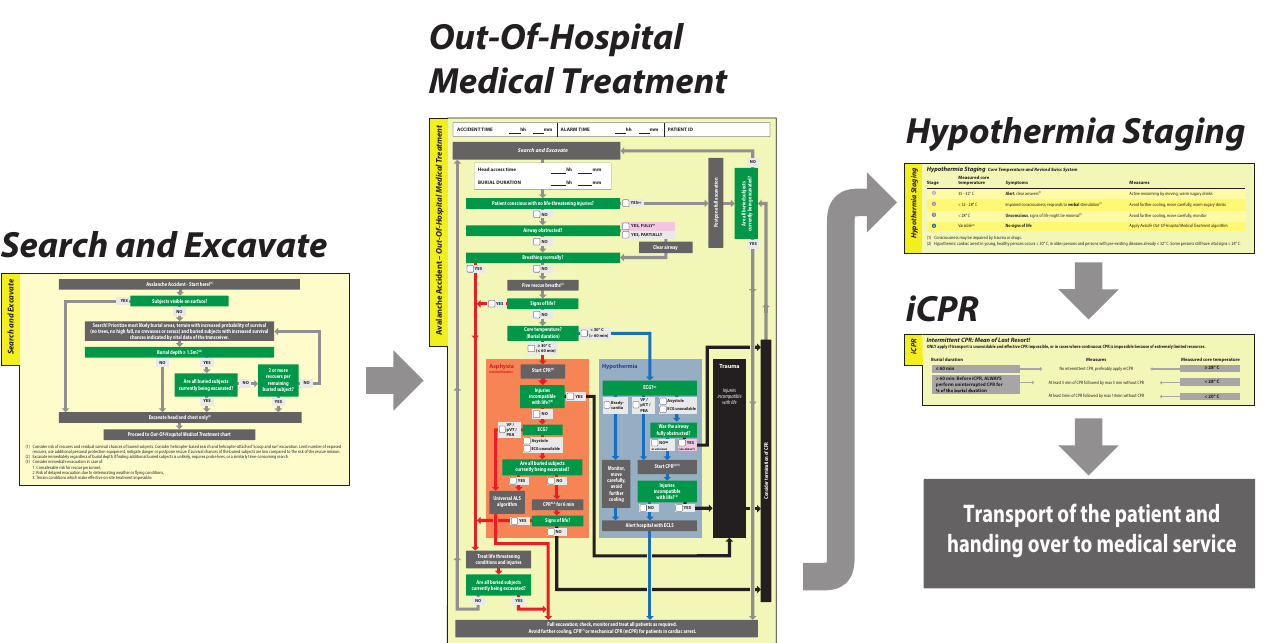
Figure 1. Overview of AvaLife BLS modules. The different AvaLife modules follow step by step the chronology of the rescue and provide critical information for the technical as well as the medical part of avalanche